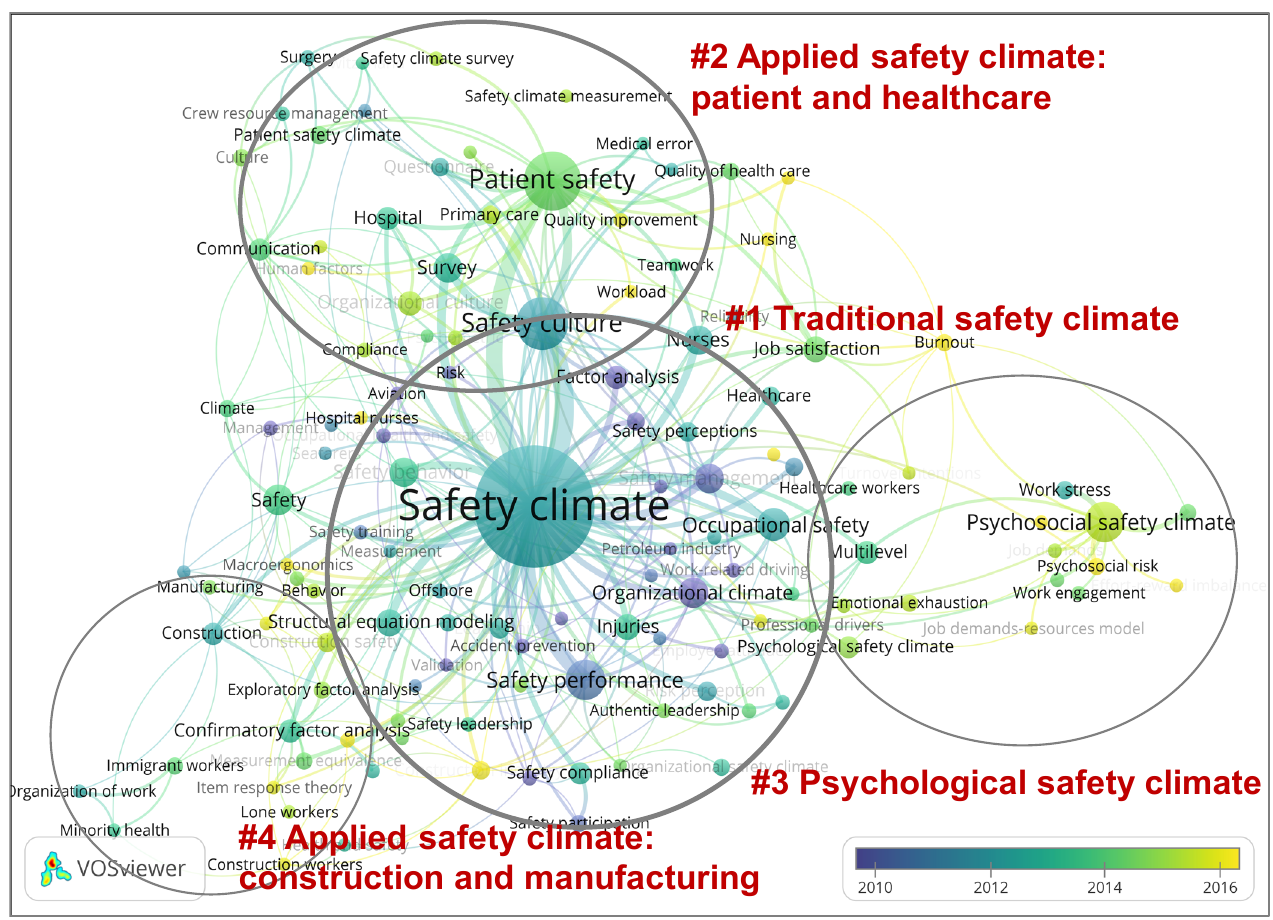
Figure 8. Clusters and average occurrence years of author keywords in safety climate research (generated using VOSviewer; see Section 2.2 for references)